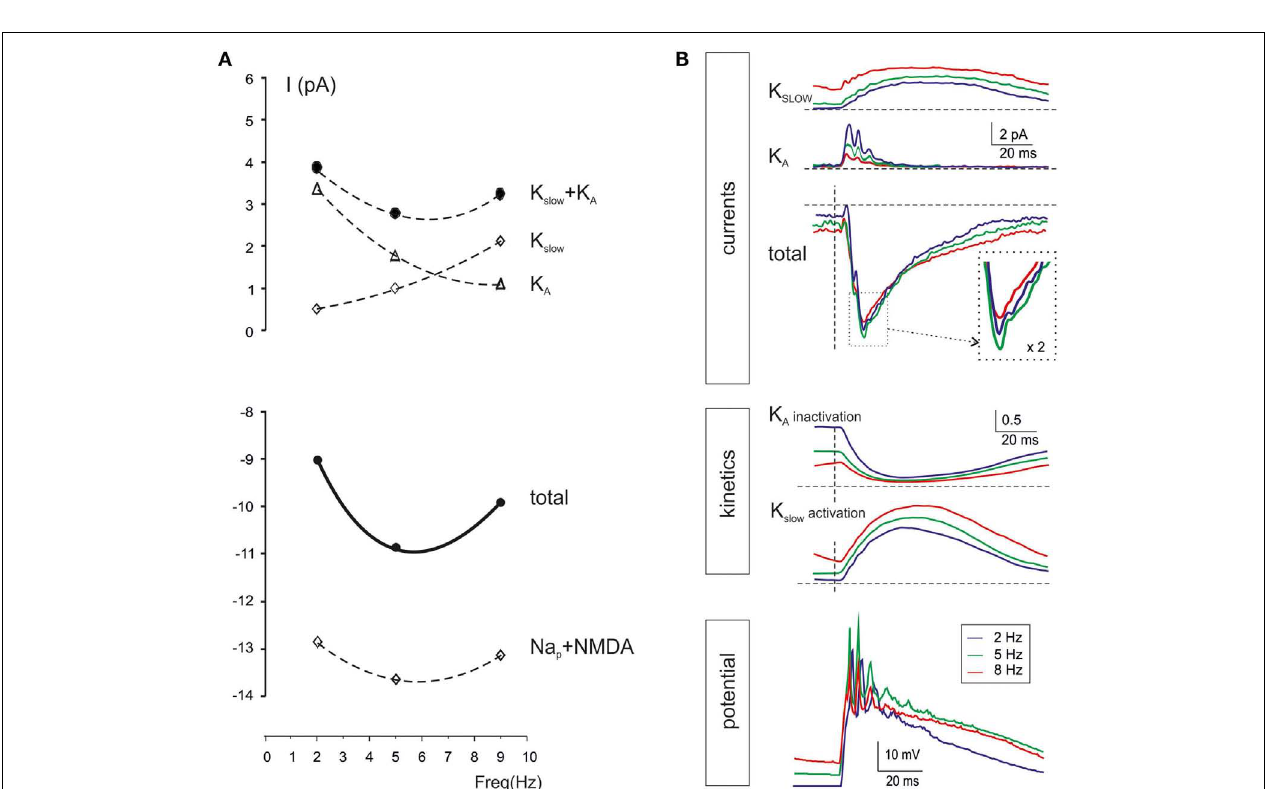
i KA and i K slow during simulated granule cells bursts delivered at frequencies of 2, 5, and 9Hz. Note the enhancement of the total current at 5Hz.The plots in the middle show the kinetics of K slow activation and KA inactivation. Note that K slow accumulated activation with frequency, whereas KA accumulates inactivation with frequency, explain the global resonant effect of their combination.The bottom tracings show membrane potential at the three different frequencies. All traces are taken from the simulations with two active excitatory and inhibitory synapses (average of 25 of 30 consecutive traces, the first 5